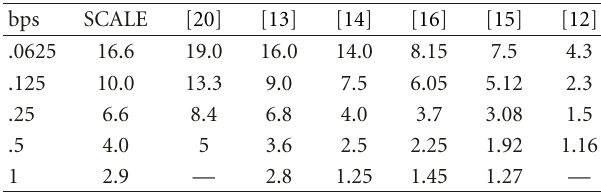
Table 2: Evaluation of the Tier-1’s computational load reduction achieved by SCALE (corpus ISO 12640-1) and state-of-the-art methods (as claimed in the literature). Results are reported as the speed-up achieved by the evaluated method when compared to